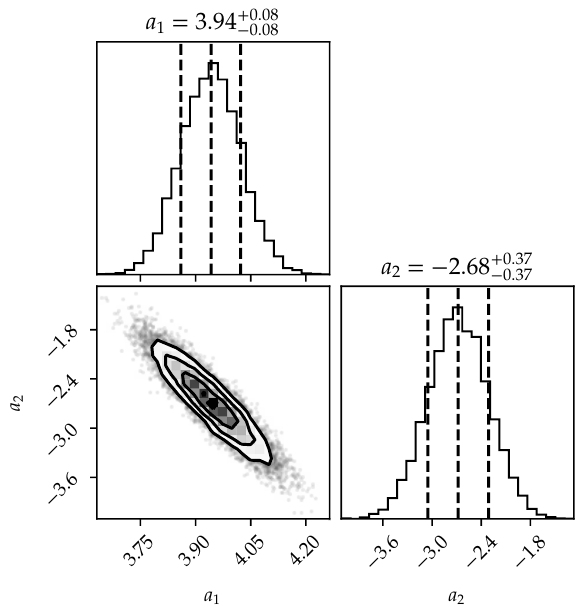
Figure 4. The sample of best-fit parameters for the theoretically justified model given by Equation (4) with p = 2 drawn from the multivariate normal distribution with the size of 10,000 via the obtained estimates of parameters and their covariance